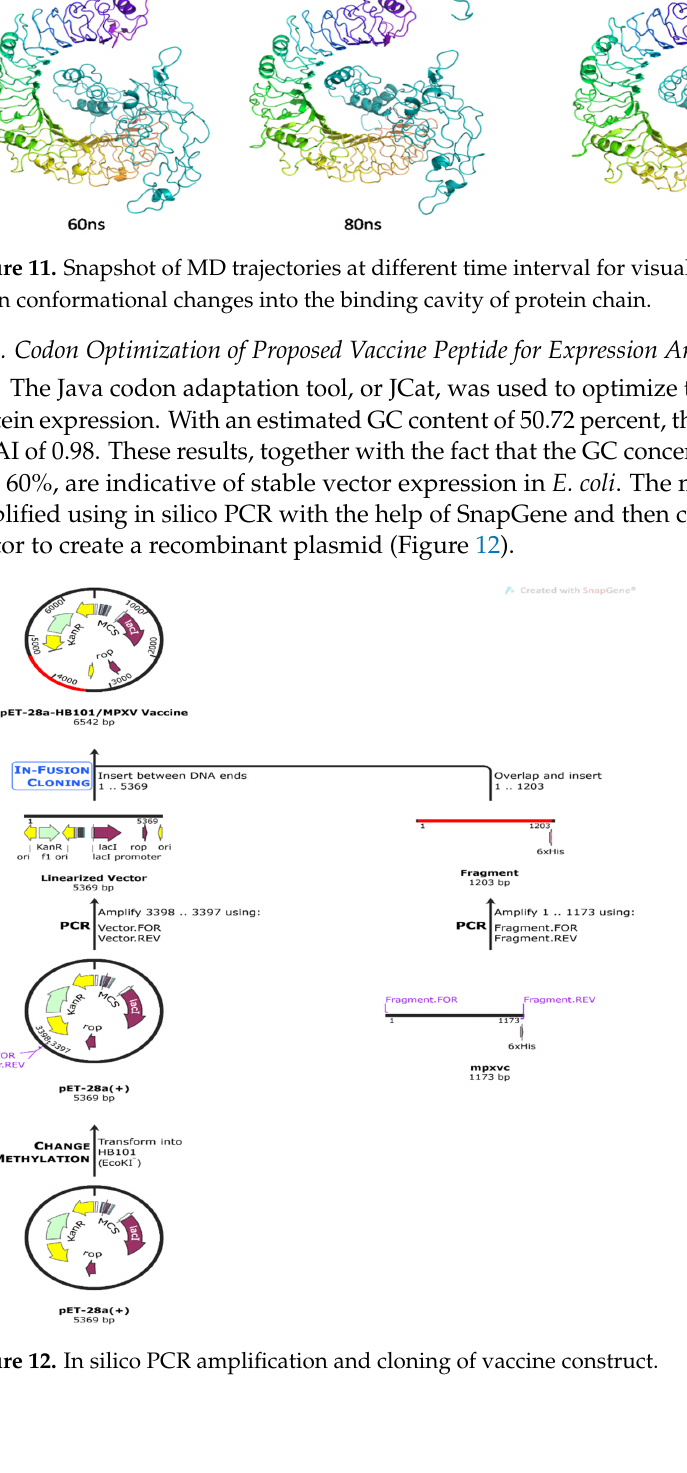
Figure 10. Analysis of MD simulation trajectories for 100 ns. ( a ) RMSD plot displaying. the molecu- lar vibration of C α backbone of protein (red) and ligand (black). ( b ) RMSF plot showing the fluctu- ations of respective amino acids throughout the simulation time 100 ns for protein. ( c ) Radius of gyration plots for the deduction of compactness of protein. ( d ) Number of hydrogen bonds formed between protein and ligand during 100 ns simulation time scale.